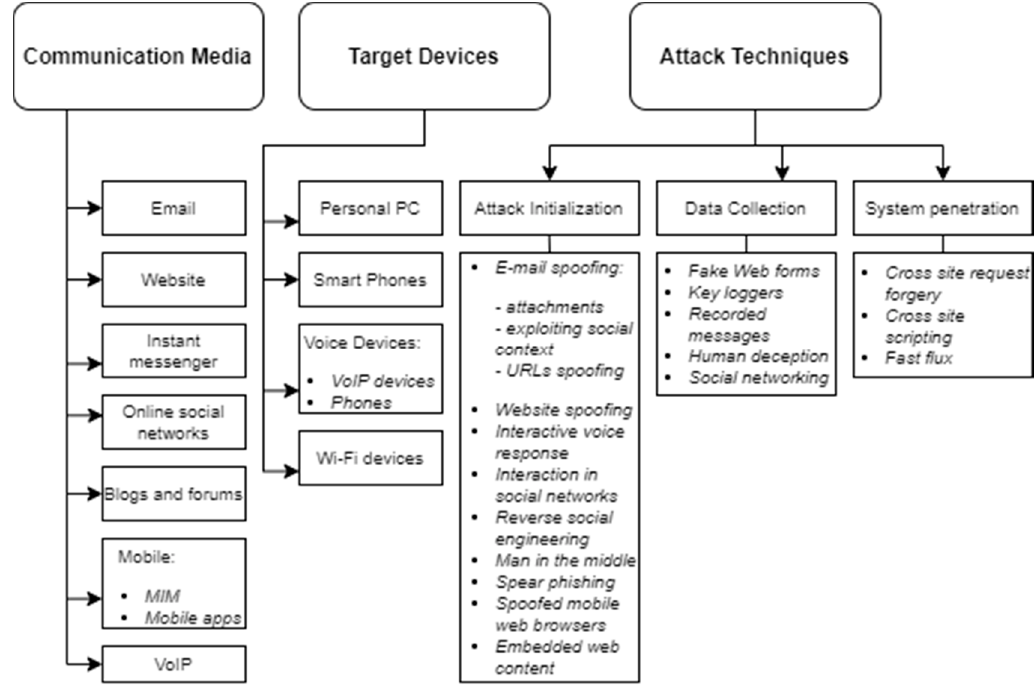
Figure 3. Phishing attack taxonomy. Reproduced from Figure 2 in [21].